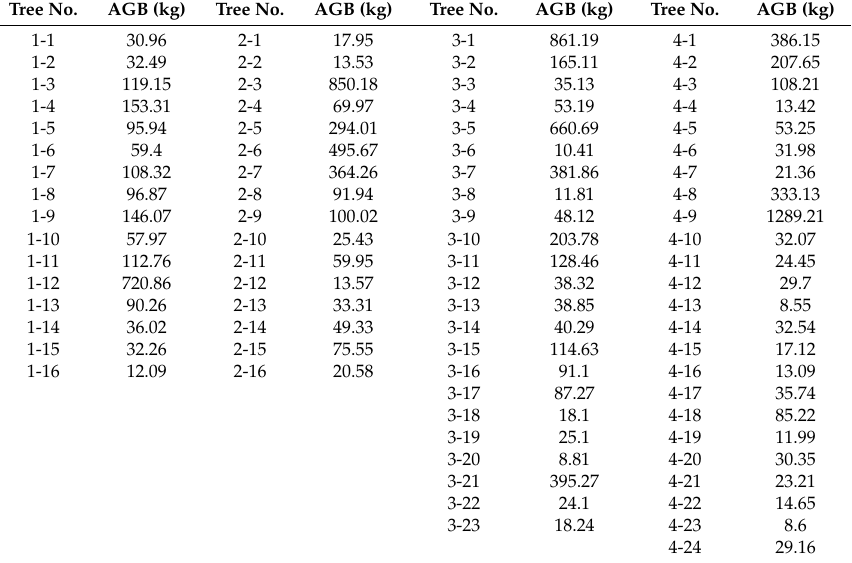
Table 1. The estimated AGBs of individual Minjiang fir trees in plots 1–4 with Formula (1). Tree No. AGB (kg) Tree No. AGB (kg) Tree No. AGB (kg)